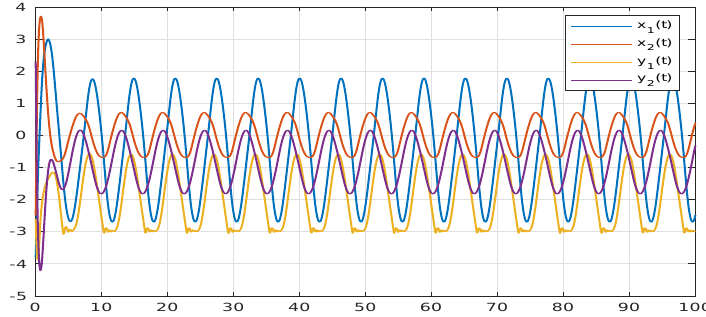
Figure 2. The drive-response MINNs without the